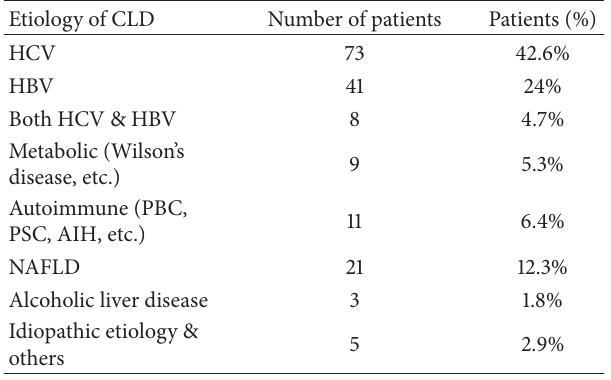
Table 1: Details of different causes of chronic liver disease in our study group.